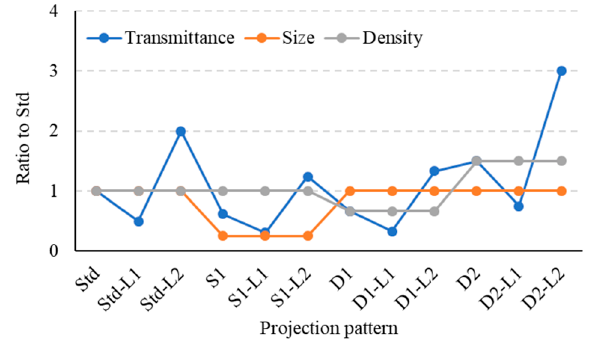
Figure 6. Component of each projection pattern.